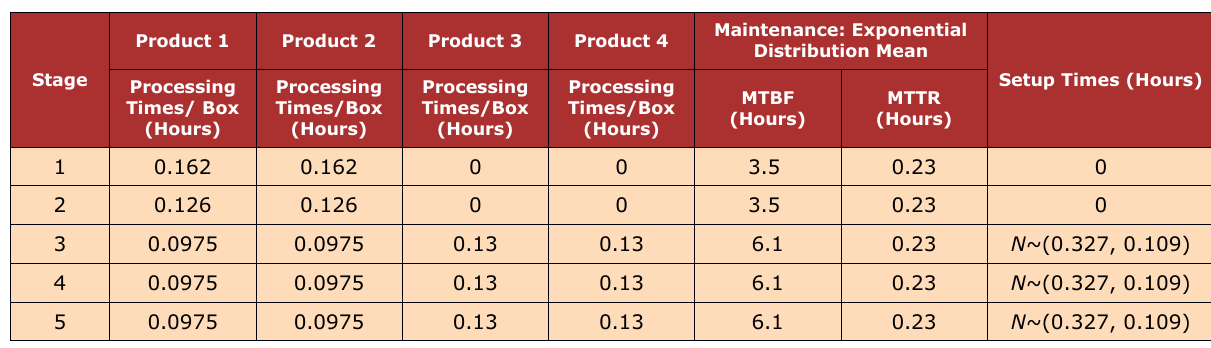
Table 4. Case-2 manufacturing system configuration